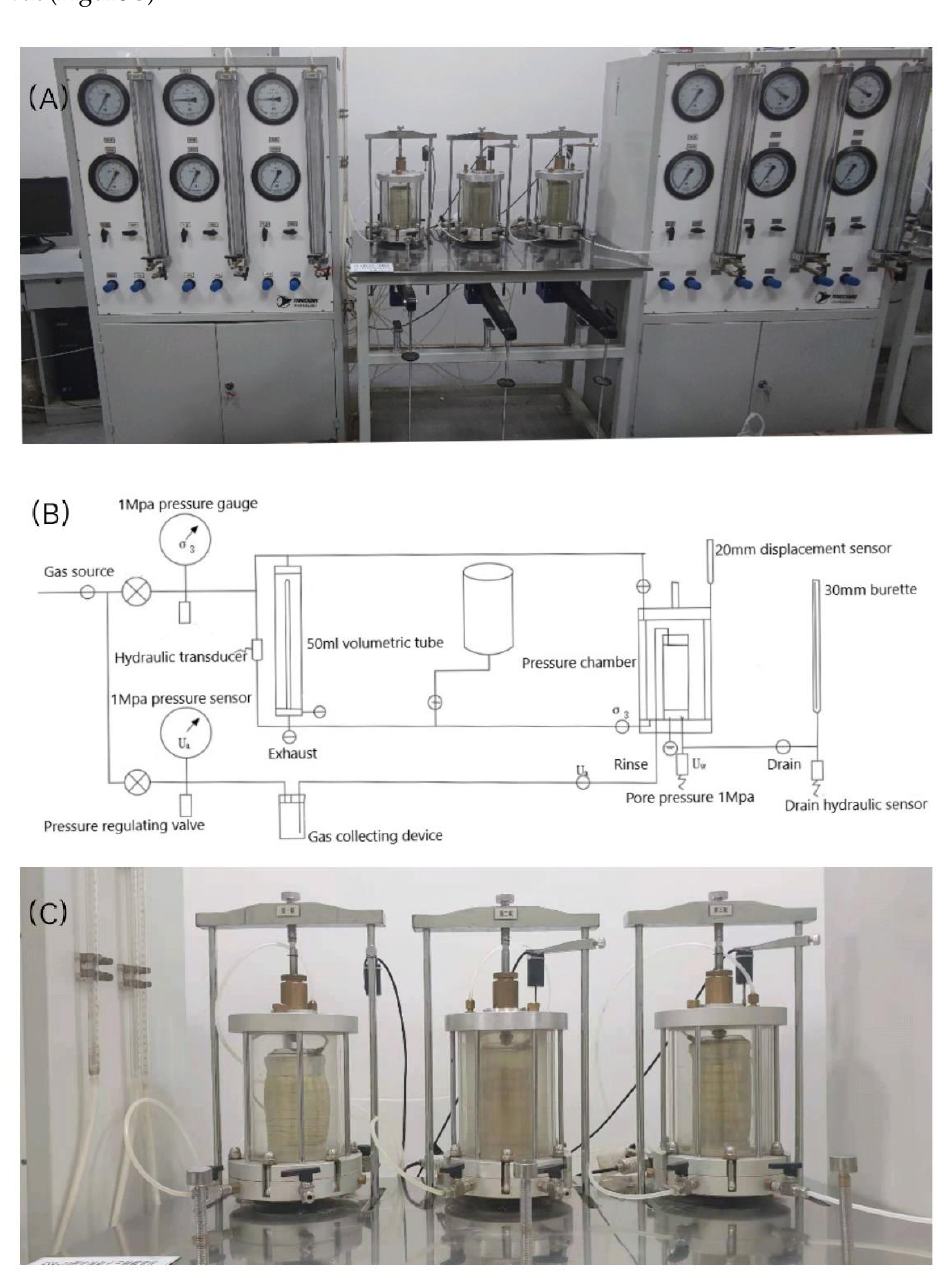
Figure 3. ( A ) FSR-20 unsaturated soil triaxial creep apparatus; ( B ) schematic diagram of creep apparatus; ( C ) creep experiment.